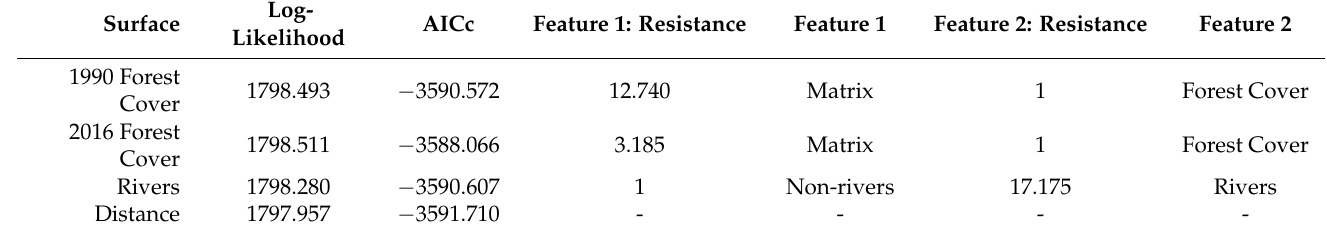
Table 3. Model results and resistance values for features within the optimized categorical single surface. For each surface, the model was parameterized using log-likelihood, and AICc is presented for corroboration.